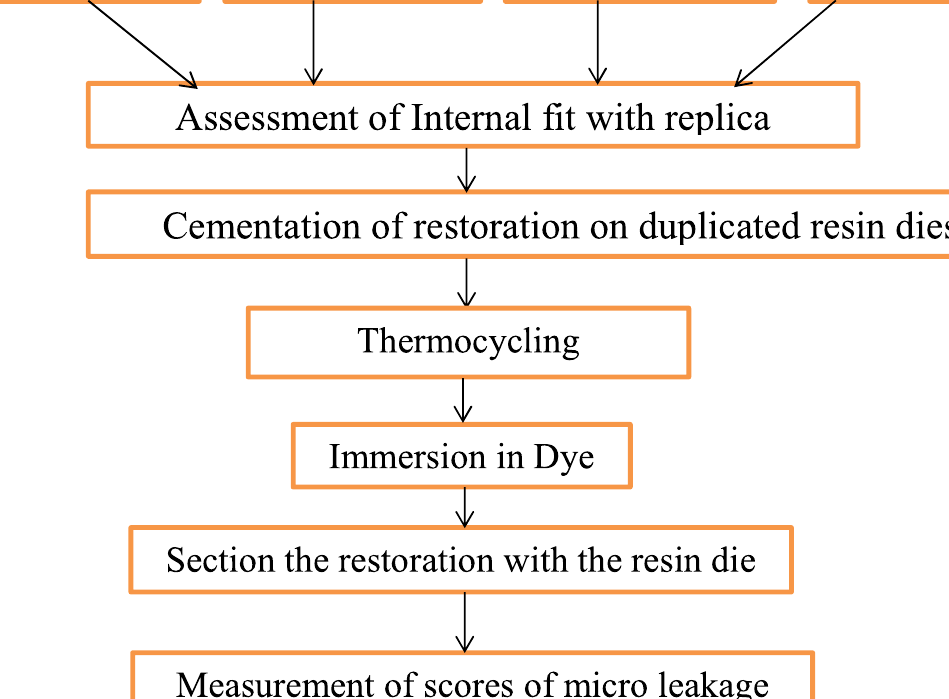
Layering technique is the principal method for veneering metalcore. Porcelain powder is mixed with modeling liquid, and the applied layer is overbuilt with a brush to compensate for fi ring shrinkage. This requires skill, multiple applications, and fi rings. 10